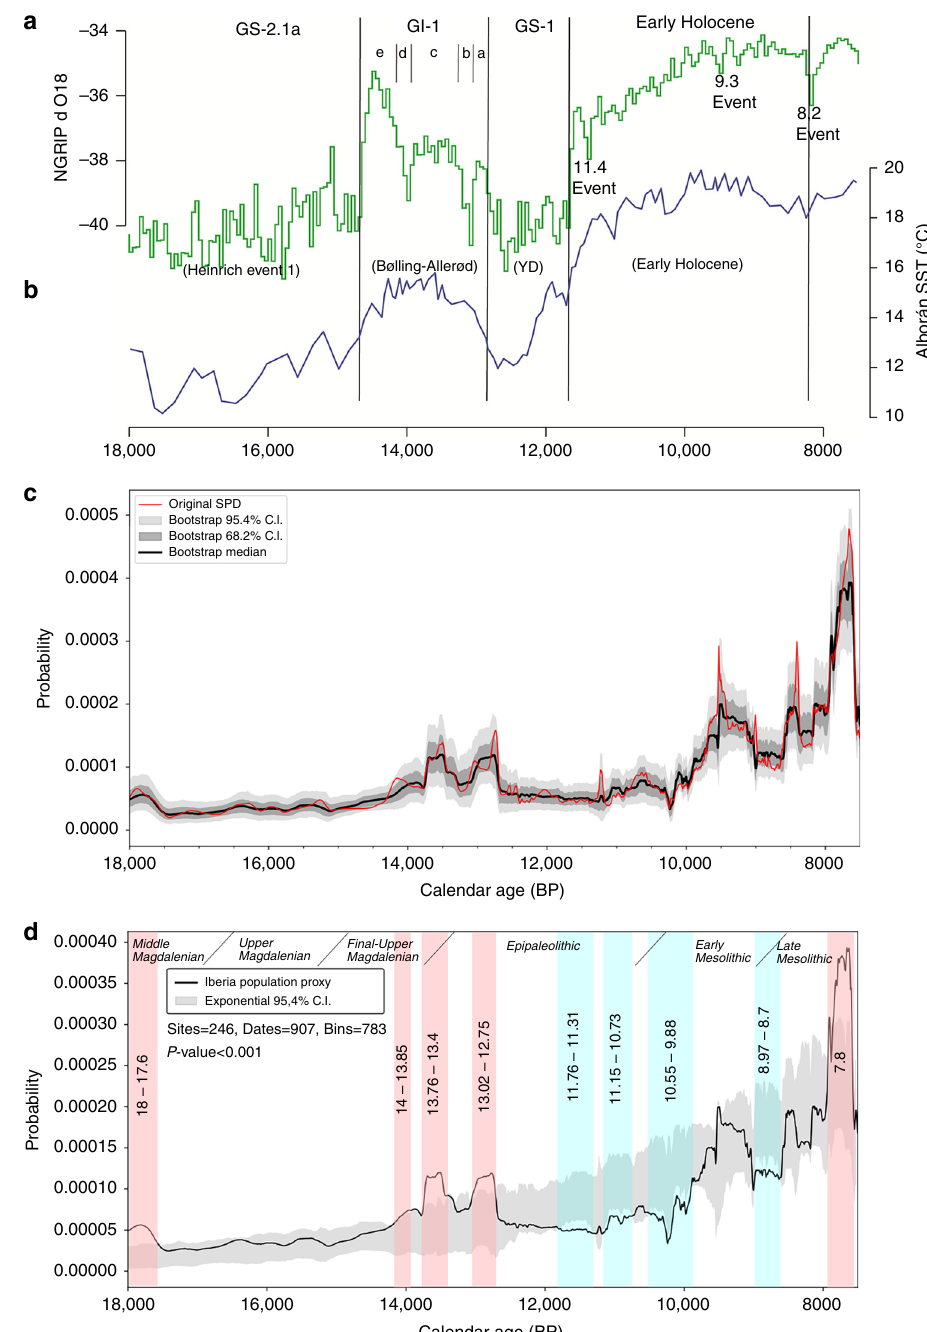
Fig. 2 SPD inferred population density changes between 18,000 and 7500 cal BP for Iberia. a , b Palaeoclimatic framework of the Last Glacial-Interglacial transition. a The green curve represents the variation of 18 O from the NGRIP ice-core record with the Greenland stratotype chronology 77 . b The blue line depicts the reconstruction of Sea Surface Temperature based on the deep-sea core MD95-2043 in the Alborán sea, considered as a palaeoclimatic proxy speci fi c to the Iberian Peninsula 56 . c Summed Probability Distribution (SPD) of the calibrated radiocarbon dates after applying bootstrap simulations on the taphonomically corrected SPD curve (in black) (seeMethods). d Population proxy (in red) plotted against a bootstrapped null model of exponential growth. Light red and light blue shaded regions denote positive and negative deviations from the null model of exponential demographic growth respectively. The global p value is calculated using the computational method of Timpson et al. 8 for a set of simulated SPDs and express the global signi fi cance of the curve's departure from the exponential null